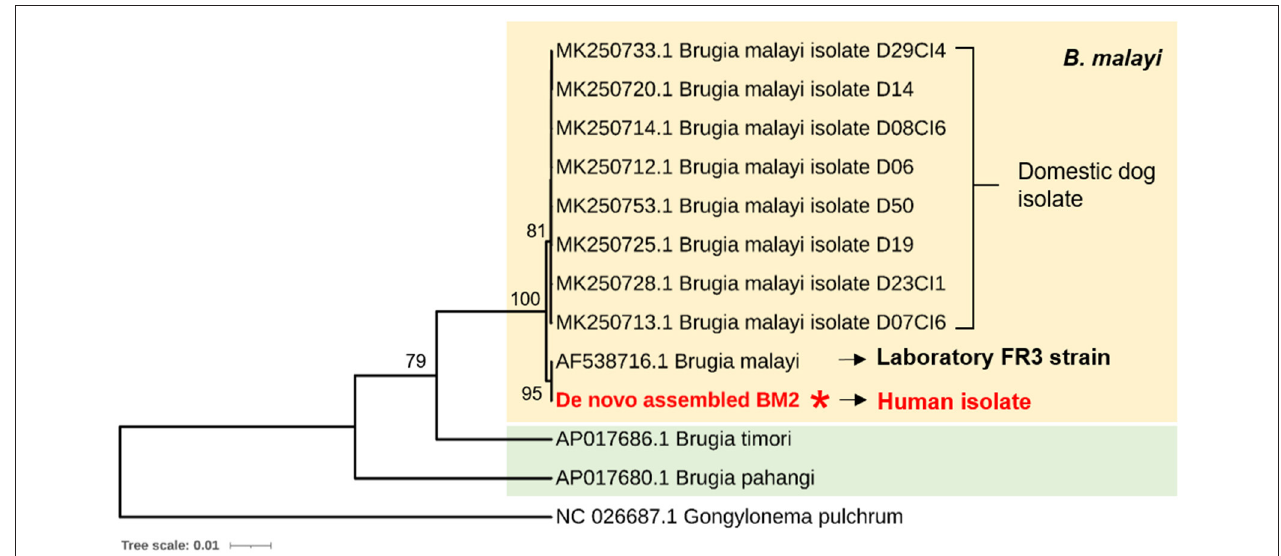
FIGURE 3 | Cytochrome c oxidase subunit I ( COX1 )-based phylogenetic analysis to identify potential sources of human brugian filariasis. COX1 genes were obtained from two human isolates; one from Thailand ( de novo assembled BM2 mt) and another from FR3 strain, and eight isolates of B. malayi collected from domestic dogs in Bangkok, Thailand. The COX1 gene of Gongylonema pulchrum , a free-living nematode, was used as outgroup control.